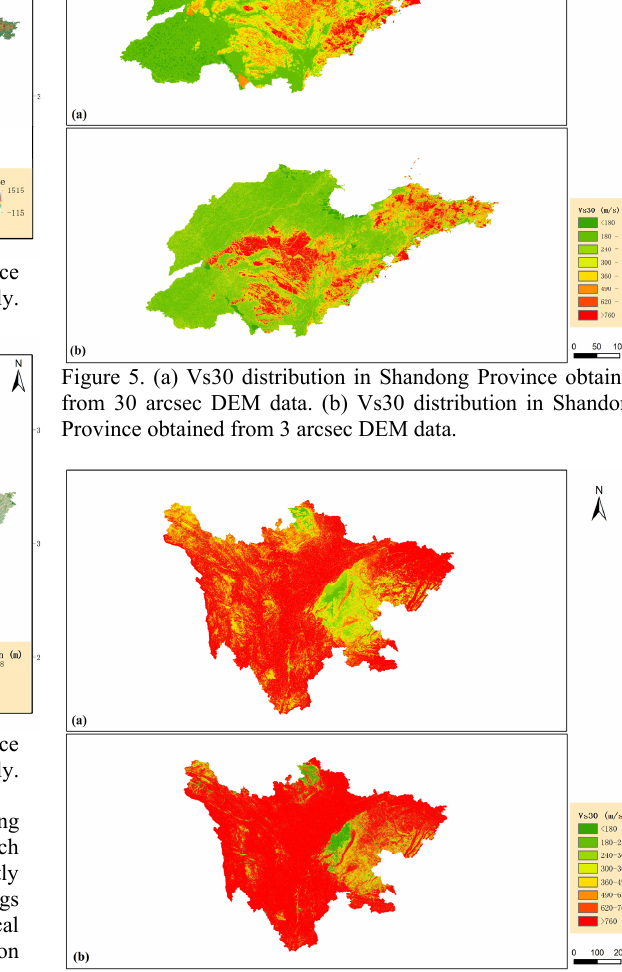
Figure 6. (a) Vs30 distribution in Sichuan Province obtained from 30 arcsec DEM data. (b) Vs30 distribution in Sichuan Province obtained from 3 arcsec DEM